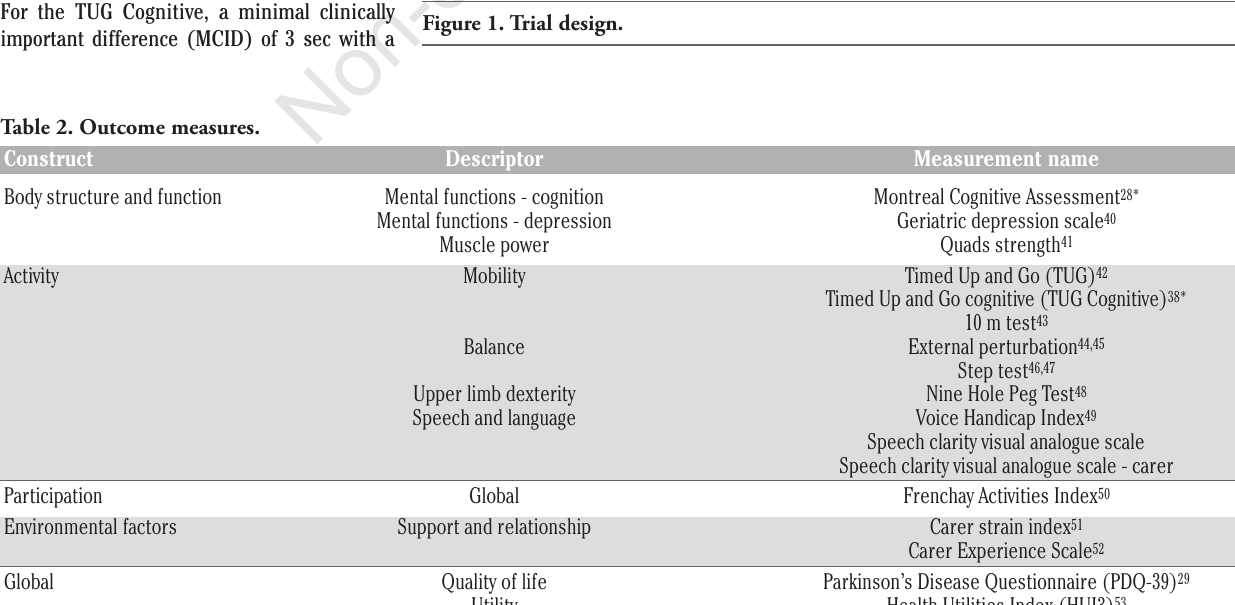
Table 2. Outcome measures.